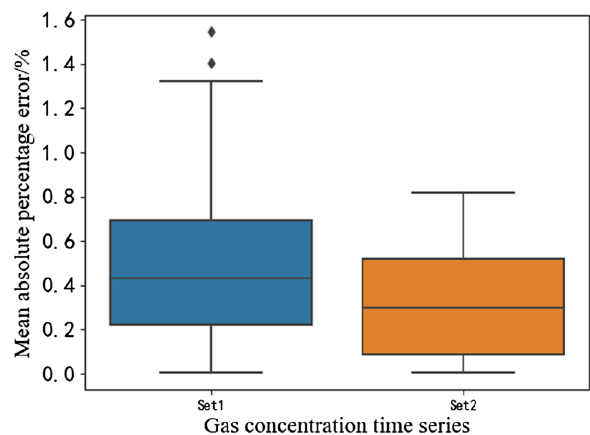
Figure 2. Prediction result error box plot.